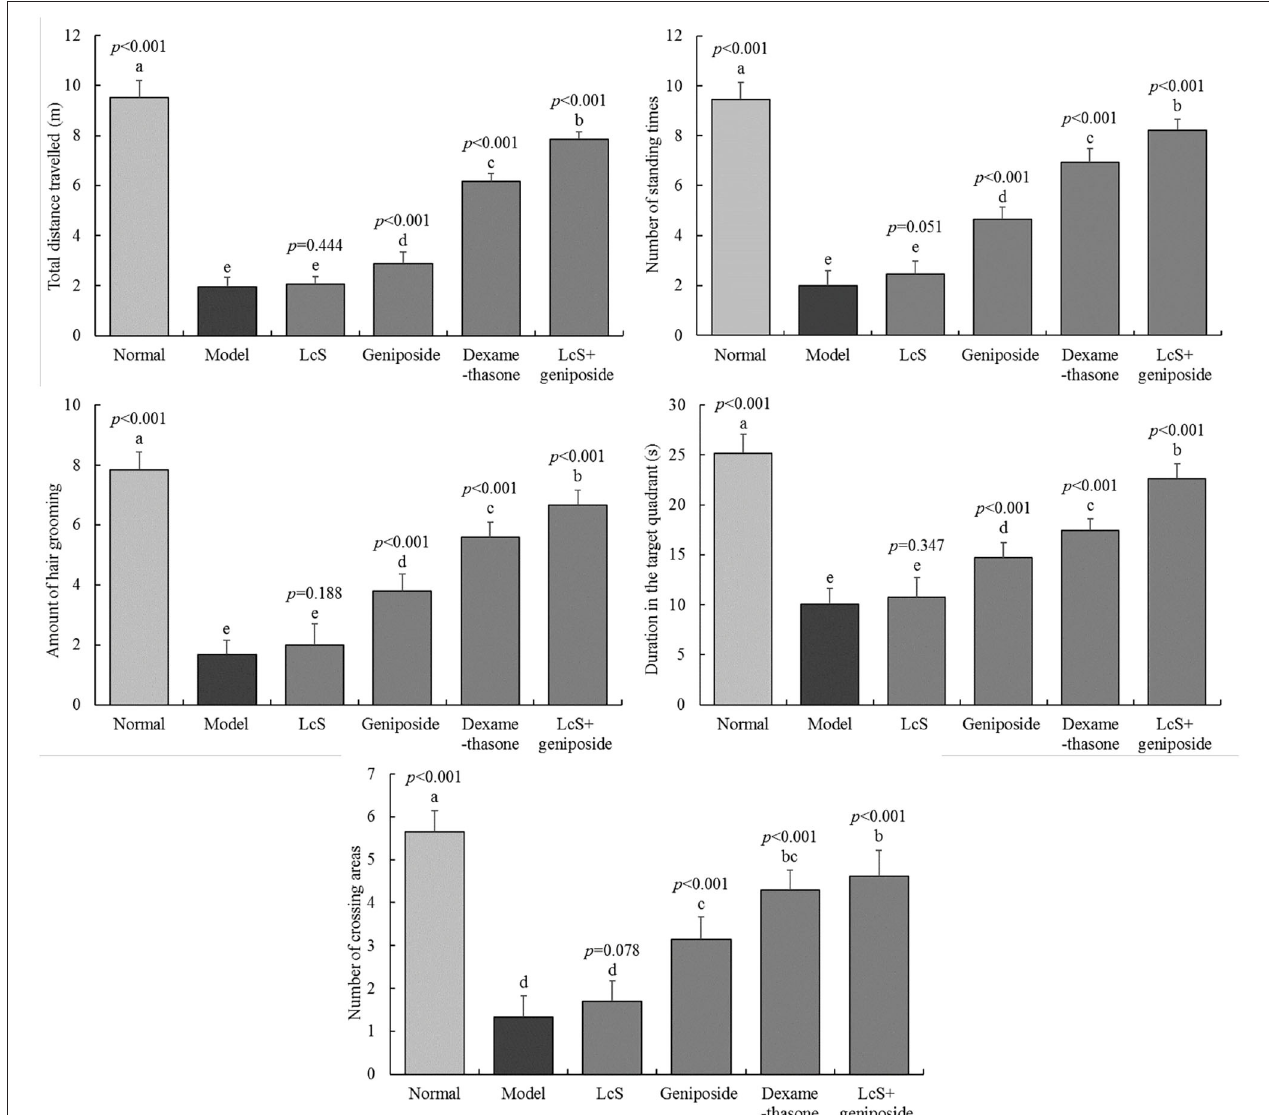
FIGURE 2 | Total distance traveled, number of standing episodes, number of self-grooming episodes, time in the target quadrant, and number of times to cross the area of mice with sepsis in different groups on the seventh day. The mean values are tabulated with mean ± standard deviation, and the p -value is the relative situation of the corresponding group to the model group. Normal: untreated mice ( n = 20), model: mice with induced sepsis ( n = 12); LcS: 5 × 10 7 CFU/kg-treated mice with sepsis ( n = 13); geniposide: 50 mg/kg geniposide-treated mice with sepsis ( n = 14); dexamethasone: 1 mg/kg dexamethasone-treated mice with sepsis ( n = 17), LcS + geniposide: 5 × 10 7 CFU/kg LcS and 50 mg/kg geniposide-treated mice with sepsis ( n = 18). a − e Mean values with different letters over the bar are significantly different ( P < 0.05) according to Tukey’s honestly significant difference